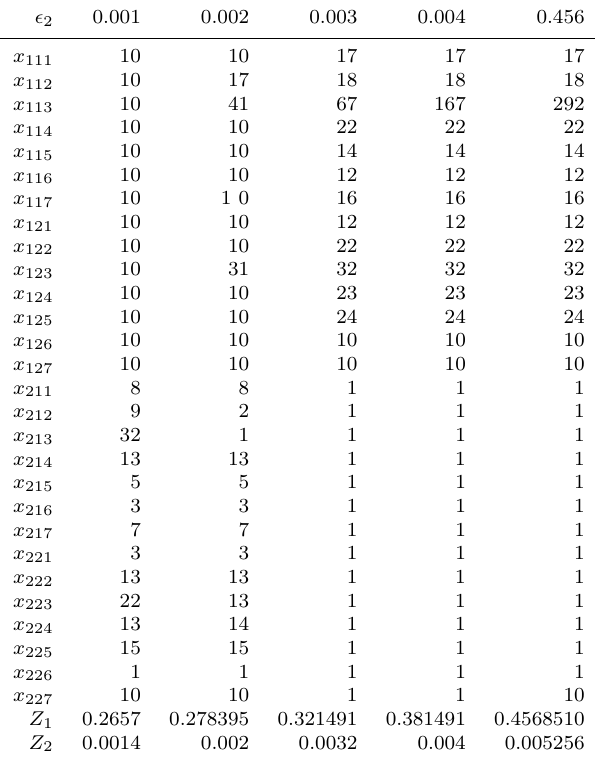
Table 8. Solutions of Z 1 and Z 2 for different values of (cid:15) 2 . (cid:15)